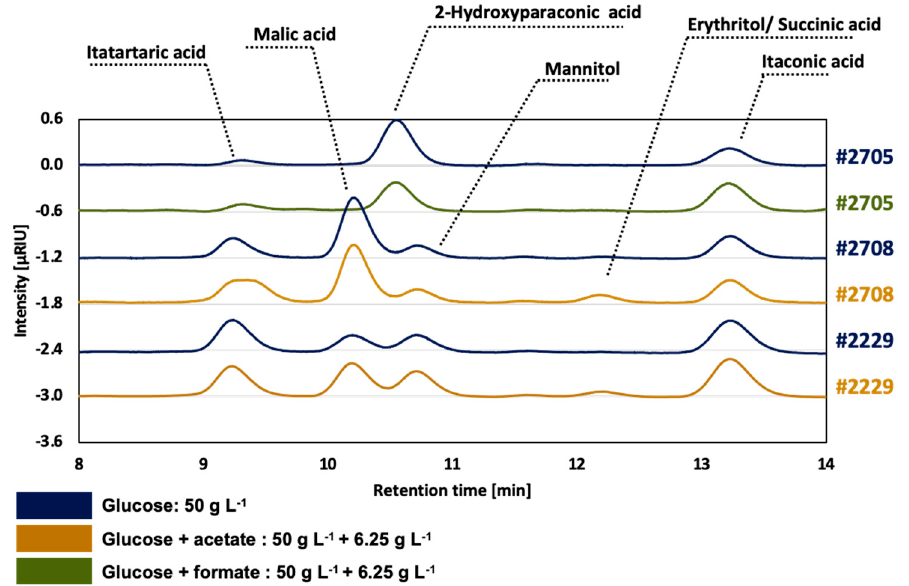
Figure 8. HPLC chromatogram overlay (RI detector). Extracellular metabolites in the supernatant formed by selected Ustilaginaceae candidates. Samples were taken after 75, 64, and 114 h of U. maydis #2229, U. rabenhorstiana #2708, and U. cynodontis #2705, respectively, during fermentation in a bioreactor containing MTM medium (0.8 g L − 1 NH 4 Cl, 30 °C, 80% DOT, at pH 6.5). Ustilaginaceae using acetate as a co-substrate are shown in orange; formate co-substrate cultivations are shown in green (6.25 g L − 1 ). Respective glucose references (50 g L − 1 ) are shown in blue.